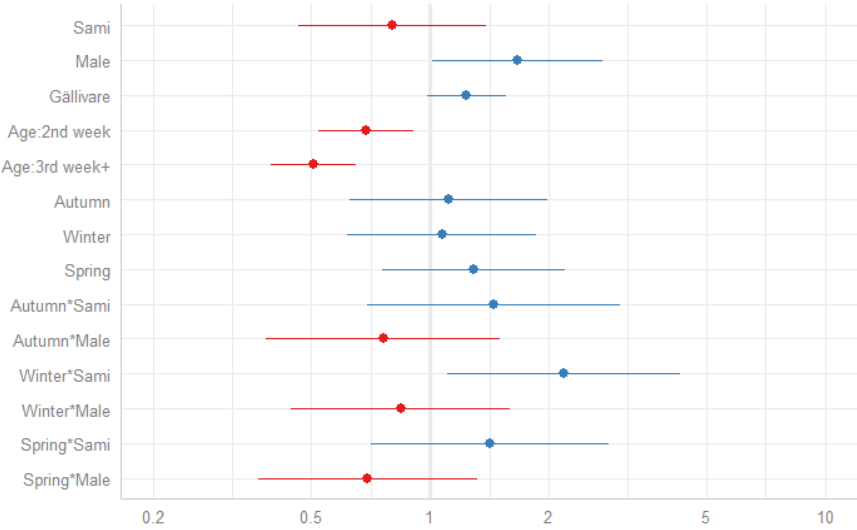
Figure 2. Hazard ratios of neonatal mortality with 95% confidence intervals (blue = increased hazard ratio, red = decreased hazard ratio), 1860–1899.